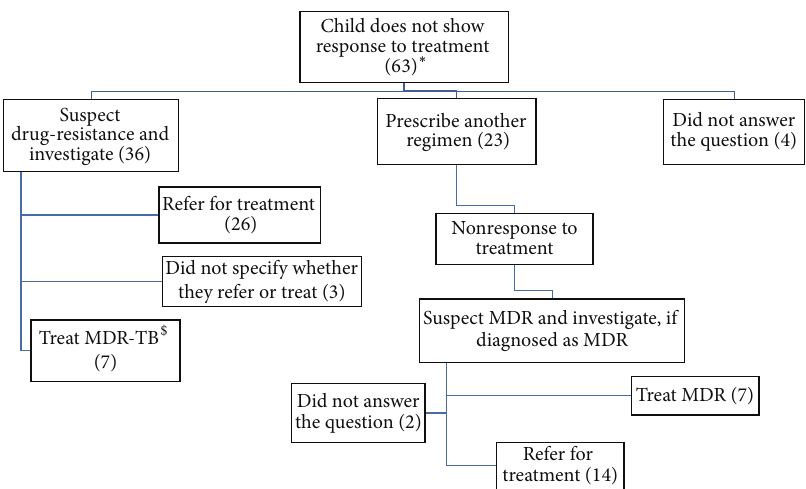
Figure1:Actionstakenbypaediatricianswhenapatientdoesnotrespondtotreatment. ∗ onepaediatricianreportedthathenevercameacross a patient who did not respond to treatment; figures in parenthesis are number of paediatricians following that practice, MDR (multidrug- resistant) TB; $ two of these seven paediatricians did not specify regimen.